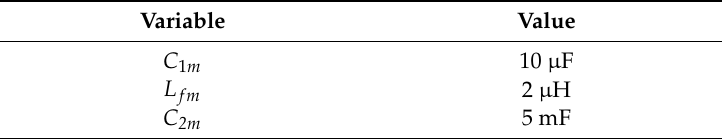
Table 5. Input filter data of the motor drive-electric motor-vehicle